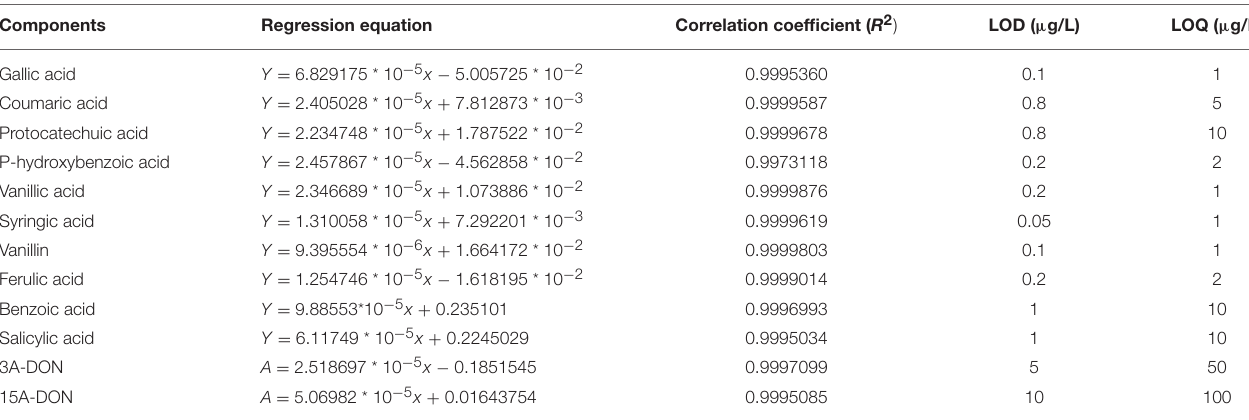
TABLE 1 | Regression equation and detectable